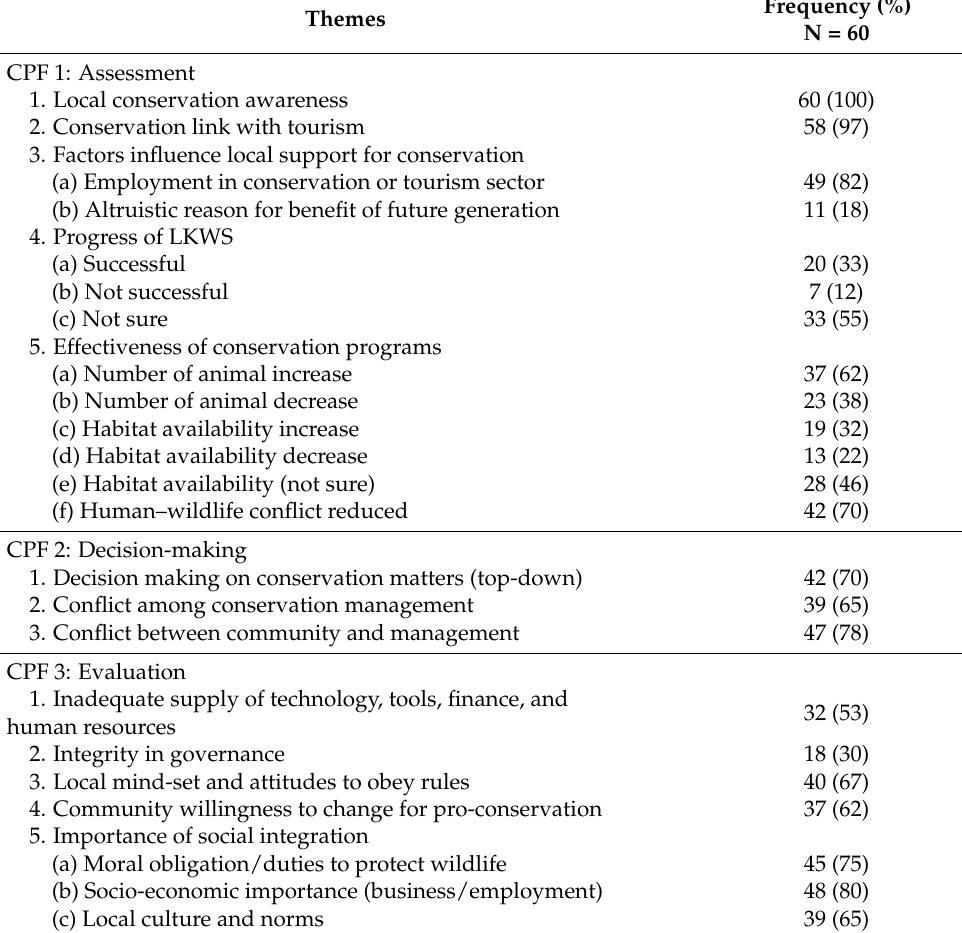
Table 1. Results of CPF based on